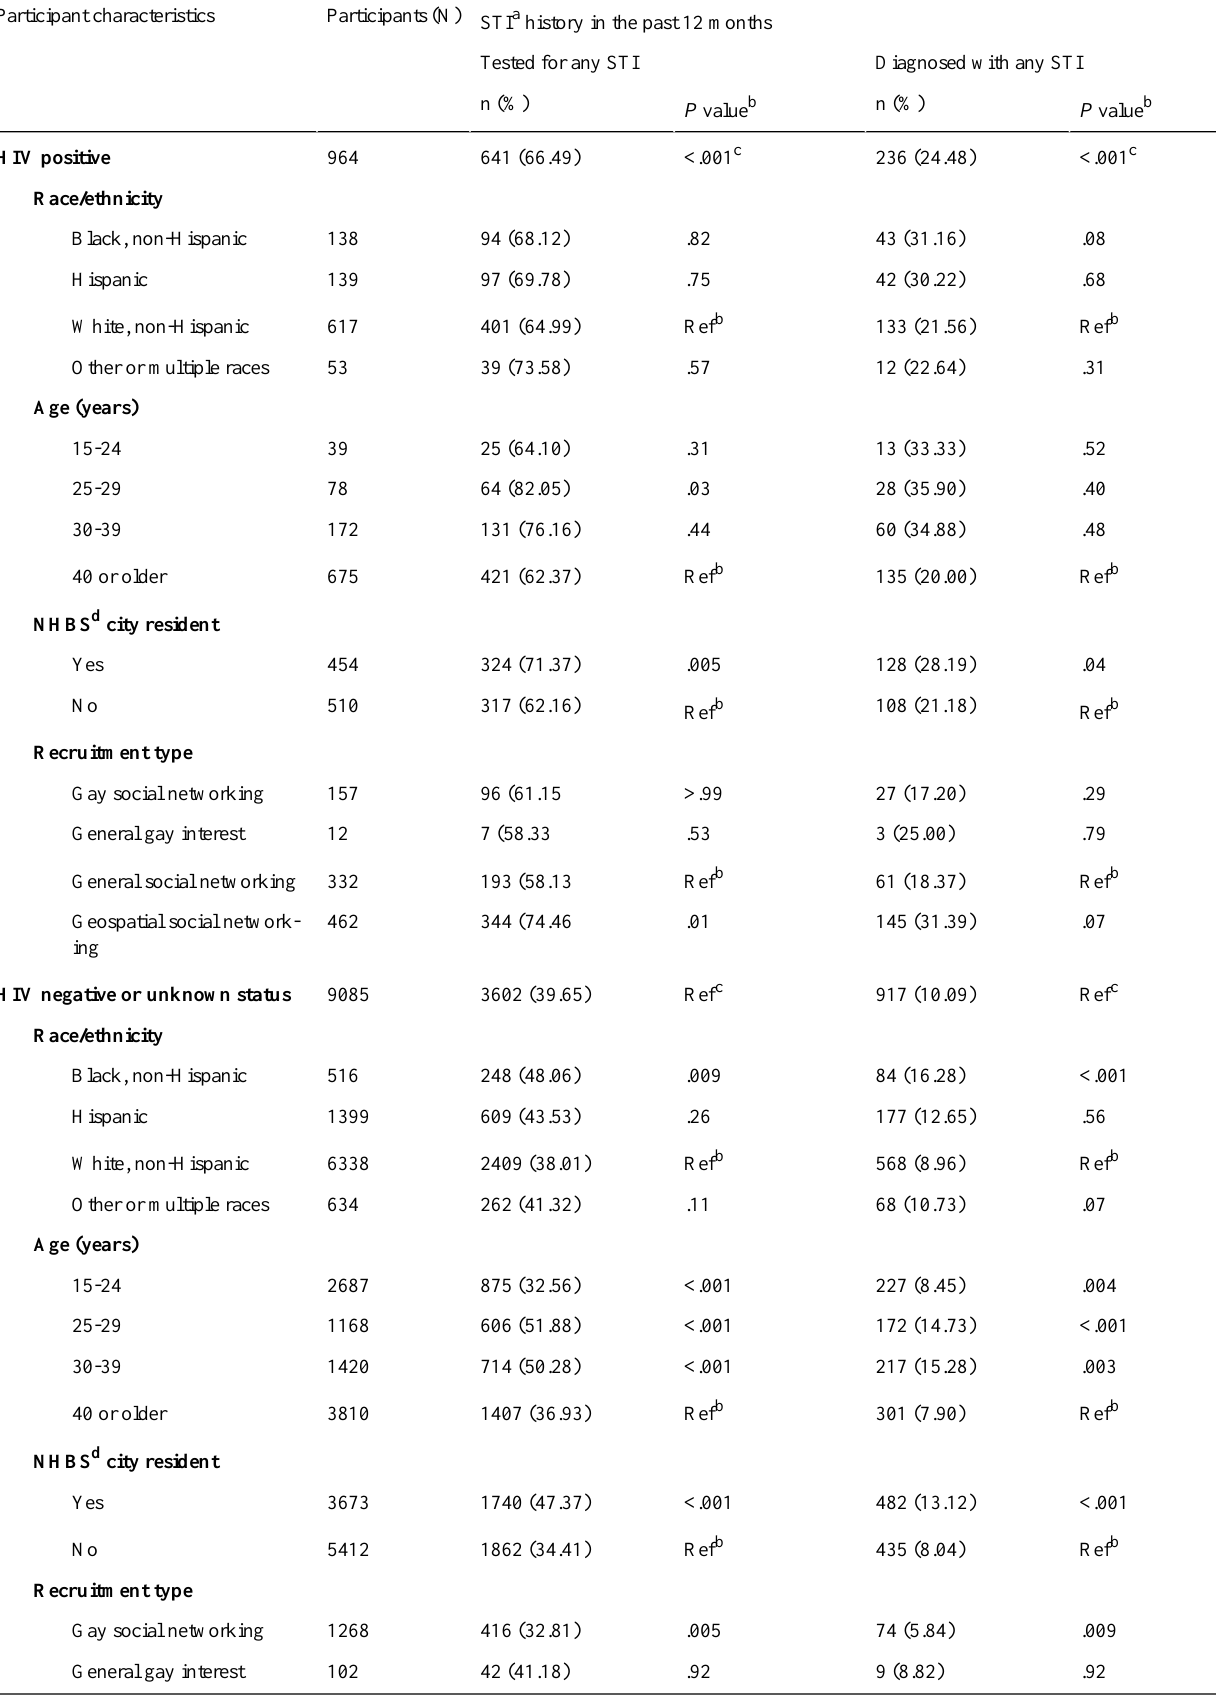
Table 6. Sexually transmitted infection testing and diagnosis of men who have sex with men in the American Men’s Internet Survey, United States,